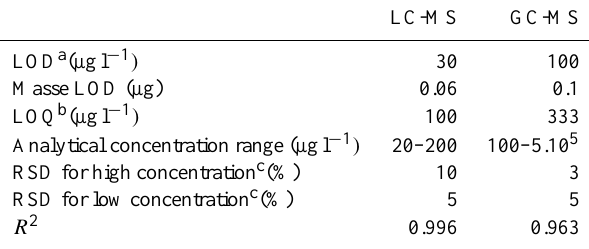
Table 2. Analytical performances and linear regression parameters of levoglucosan (same performances for mannosan and